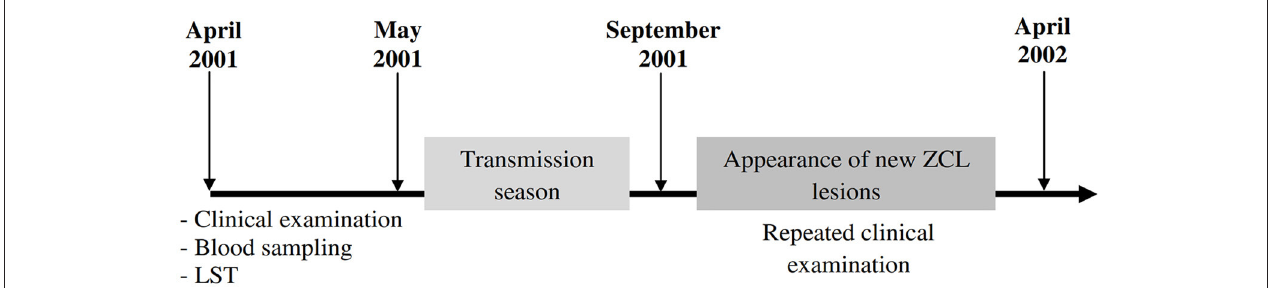
FIGURE 1 | Timeline showing progress of the prospective study. Four hundred and fifty three participants living in endemic foci of zoonotic cutaneous leishmaniasis (ZCL) in Central and Southwestern Tunisia (Gafsa and Sidi Bouzid) were followed up throughout one season of L. major transmission. Several parameters such as leishmanin skin test (LST) or the presence of typical ZCL scar were monitored at the beginning of the study. Peripheral blood samples were obtained from each donor and will be used to analyze host cytotoxic immune response. Repeated clinical examinations were done to diagnose the new cases of ZCL emerging after one transmission season (September 2001–April